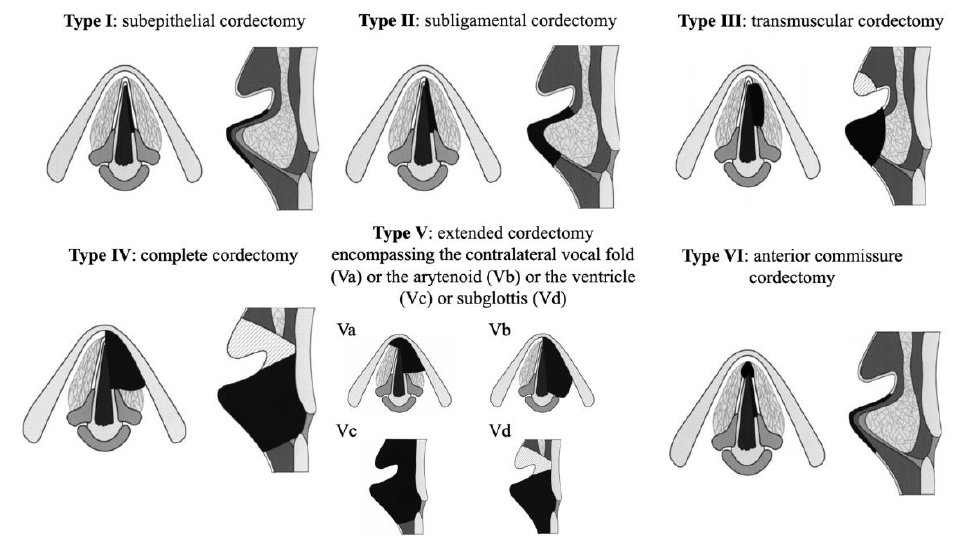
Figure 1. The European Laryngological Society classification of endoscopic cordectomies. This classification was published by Remacle et al., 2000 [9] and Remacle et al., 2007